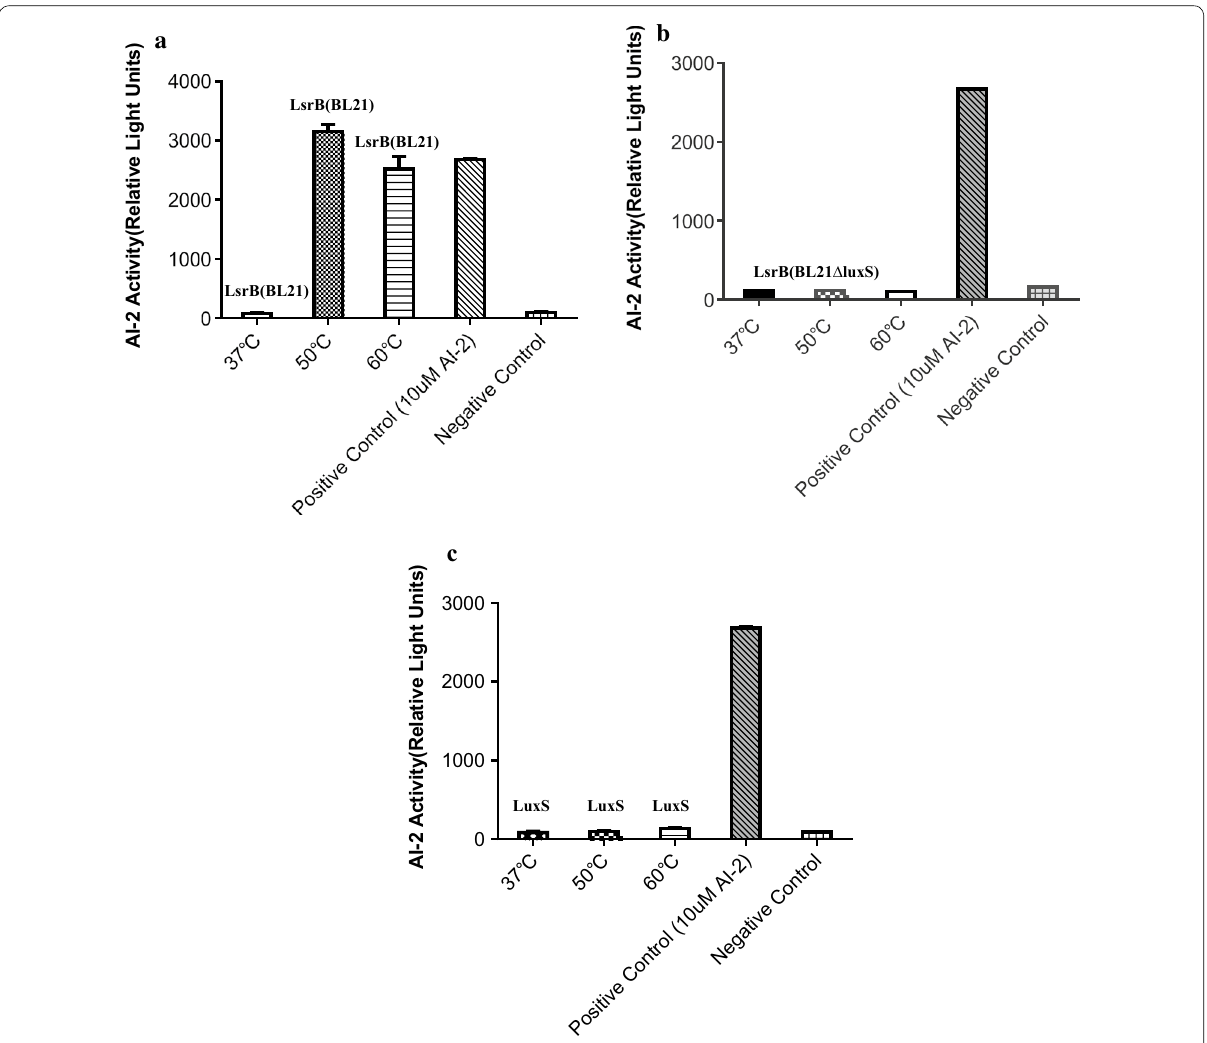
Fig. 5 Binding of LsrB to endogenous AI-2. Purified LsrB (BL21) and LsrB (BL21∆luxS) proteins (5 mg/ml) were incubated for 10 min at 37, 50 and 60 °C to release endogenous AI-2, respectively. After incubation, the LsrB proteins were removed by ultrafiltration (10,000-Da cut-off; EMD Millipore), and the filtered reaction products were tested for AI-2 activity using a V. harveyi BB170 bioassay. The extent of LsrB binding to endogenous AI-2 was evaluated using an AI-2 assay, which showed that recombinant LsrB (BL21) bound to endogenous AI-2 (produced by wild-type strain BL21) and was released from LsrB (BL21) at 50 or 60 °C, respectively ( a ). However, since the luxS mutant BL21∆luxS did not produce endogenous AI-2, no AI-2 could be released from the recombinant LsrB (BL21∆luxS) ( b ). Moreover, the recombinant LuxS protein, which was expressed in strain BL21 (pColdTF-lsrB) as a negative control, also showed no AI-2 binding activity ( c ). AI-2 (10 μM) was used as a positive